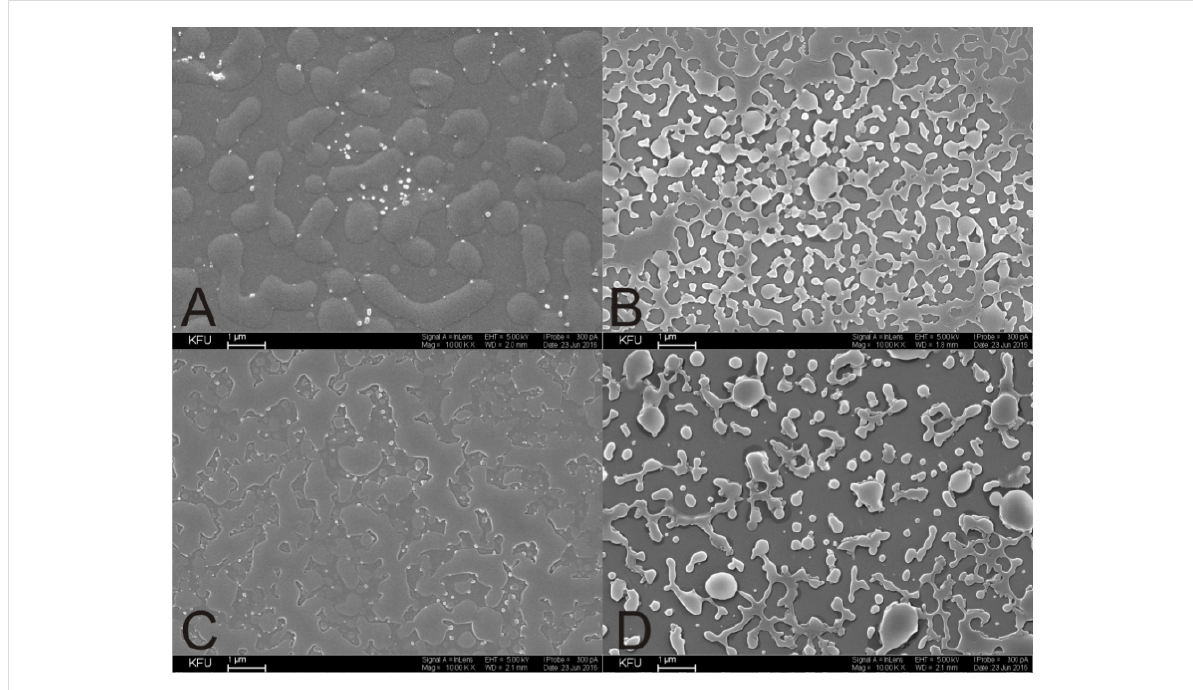
Figure 2: SEM images of self-associates based on thiacalix[4]arene: А ) compound 8 , B) compound 9 , C) compound 10 , D) compound 11 in water (1 × 10 − 4 М ). Scale bar 1 µm.